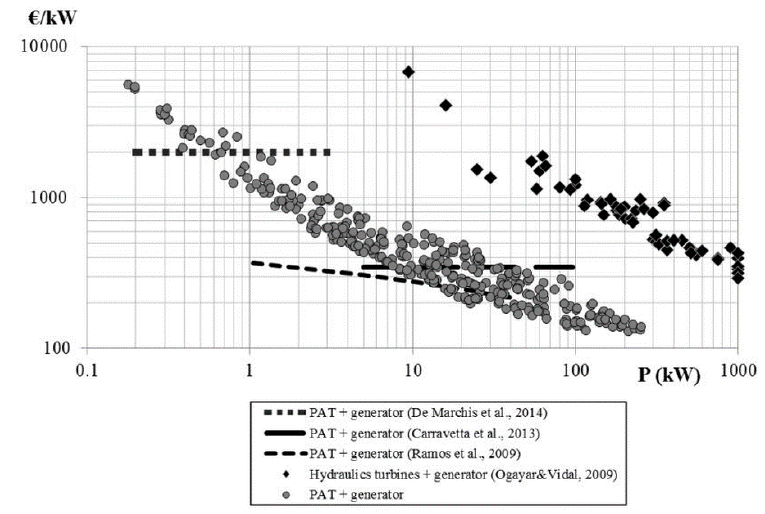
Figure 13. Unit cost per rated power of PATs and conventional turbines coupled to generators [50], compared to other literature cost models [51–54] .